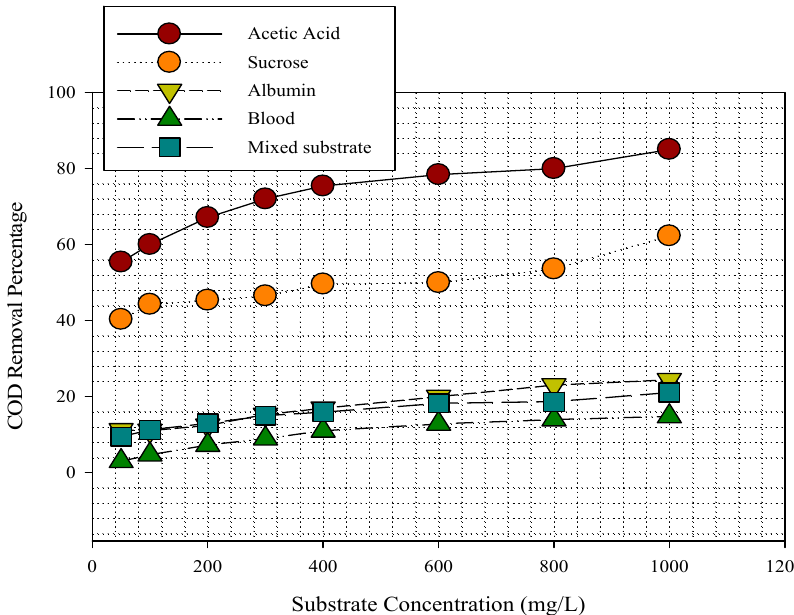
Figure 4. Substrate removal (COD) percentage at various substrates concentrations in MFC.